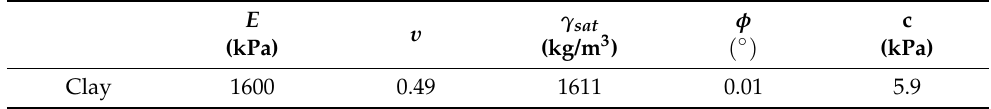
Table 2. Material properties of the M–C model.